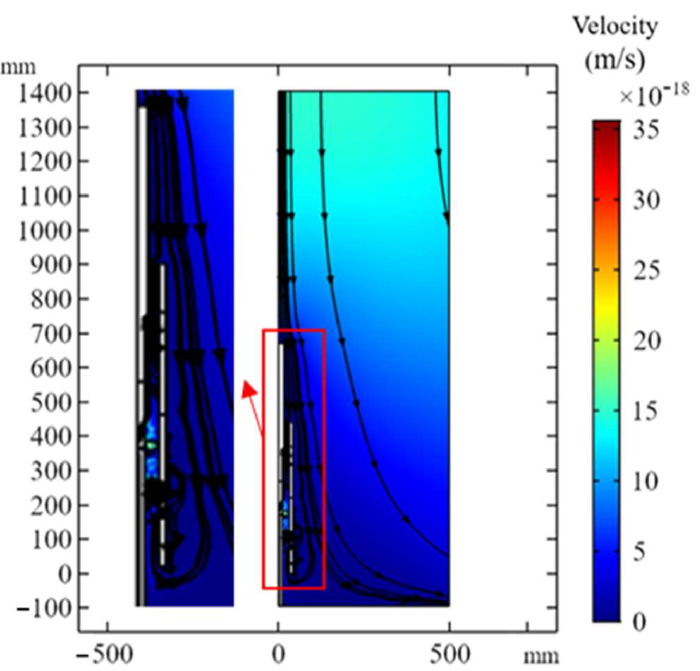
Figure 5. The airflow field and flow line around the furnace. The flow outside the furnace is laminar, which circles the furnace and takes heat away. A large amount of heat is discharged from the upper and lower ports by continuous air exchange. The temperature field shown in Figure 6 is in a “gourd” shape with the synergistic effect of airflow and the furnace’s outer thermal insulation layer when thermal equilibrium arrives in heat preservation. Moreover, the temperature 50 cm away from the furnace did not fluctuate significantly during the experiment under natural convection.